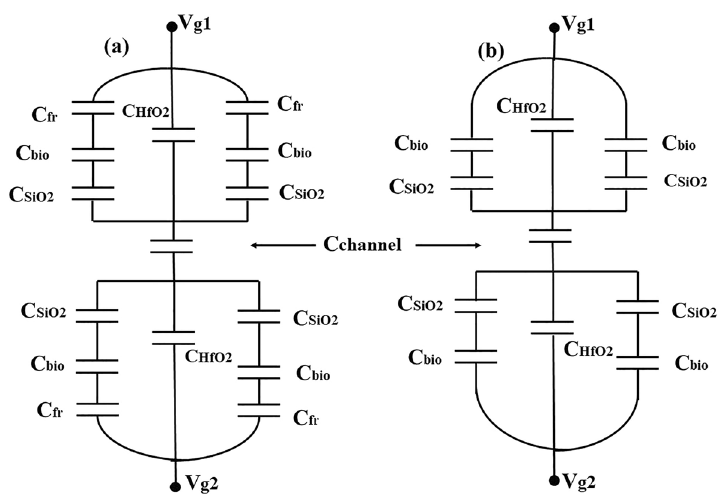
Figure 2. Equivalent Capacitance Model for ( a ) Device structure-1, ( b ) Device